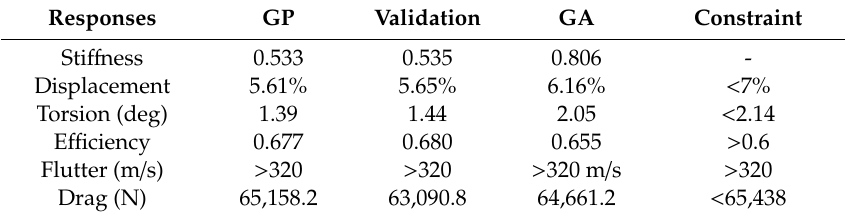
Table 3. Comparison of responses.